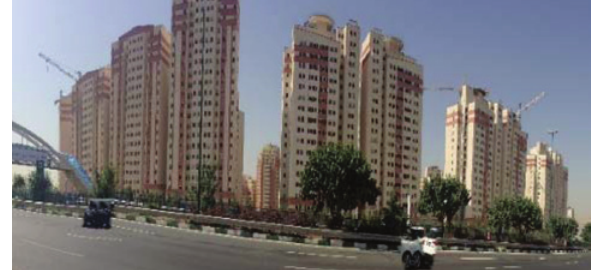
Figure 8. Panoramic photography of a sample